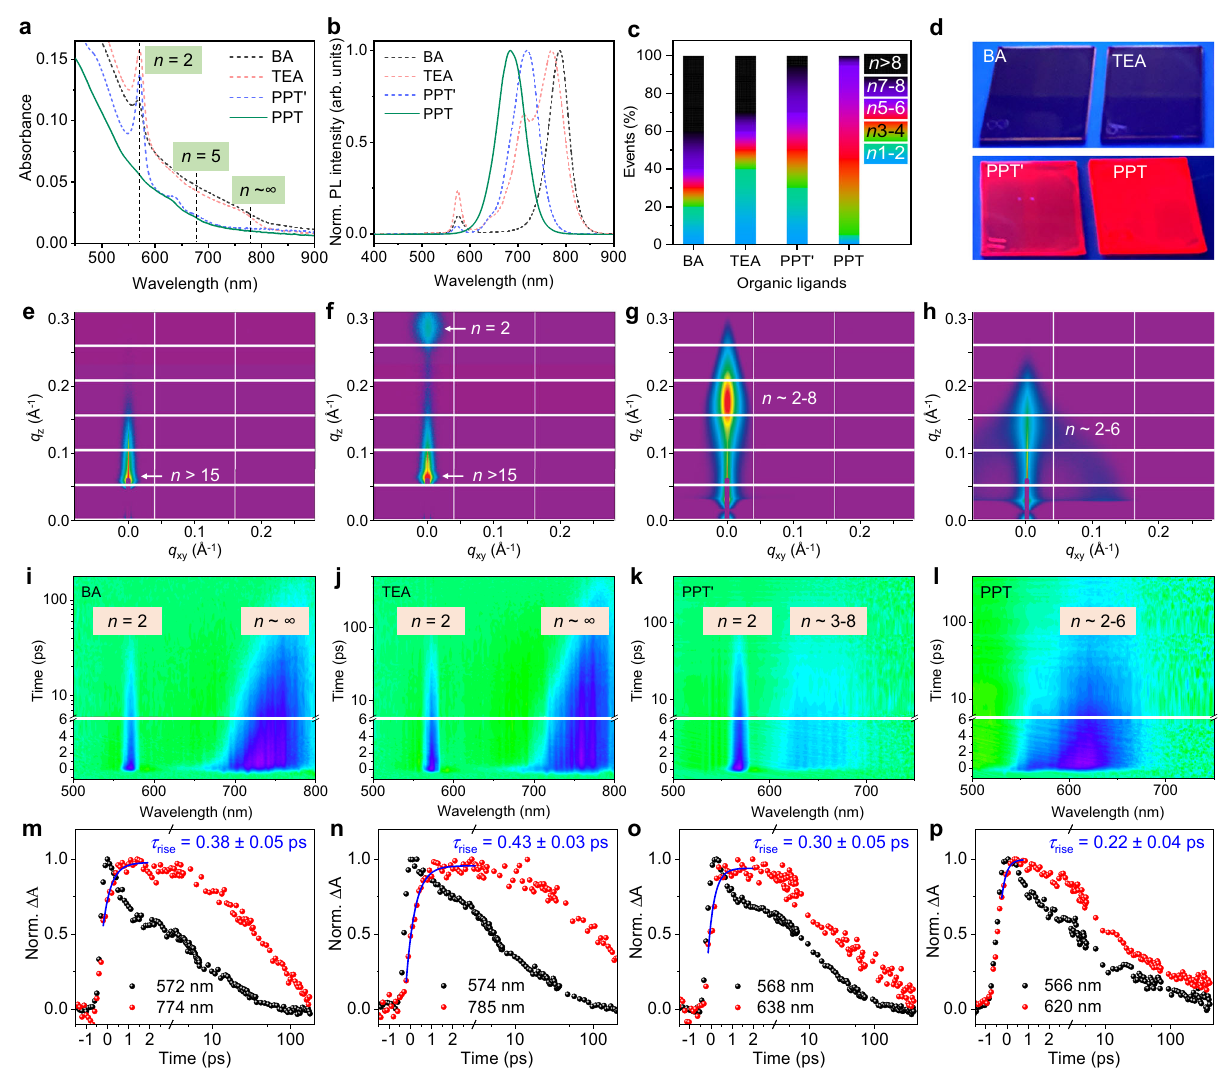
fi lms with different organic ligands under ultraviolet lamp irradiation. e – h GISAXS patternof( e )BA,( f )TEA,( g )PPT ’ ,and( h )PPTbased fi lms. q xy and q z representthe curves at two different wavelengths of ( i , m ) BA, ( j , n ) TEA, ( k , o ) PPT ’ , ( l , p ) PPT based fi lms. The energy transfer time constant is fi tted to be 0.38±0.05, 0.43±0.03, 0.30±0.05, and 0.22±0.04ps for BA, TEA, PPT ’ , and PPT fi